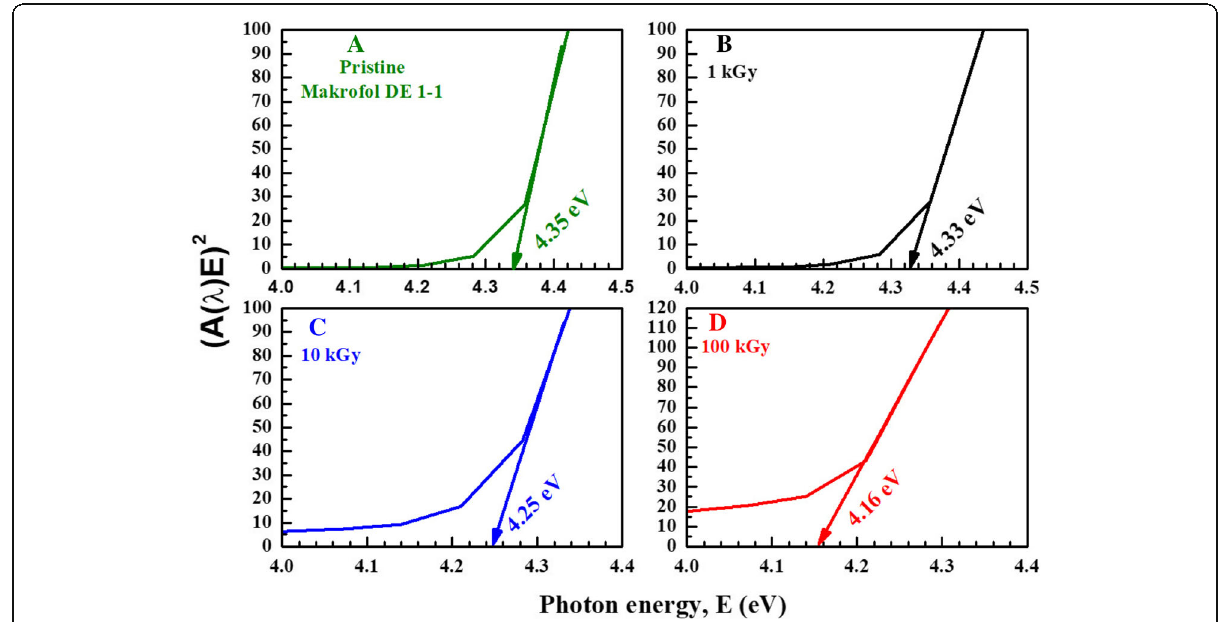
Fig. 8 Variation of ( A ( λ ) E ) 2 with ( E ): a pristine, b 1 kGy, c 10 kGy, and d 100 kGy Makrofol DE 1-1 samples irradiated with gamma